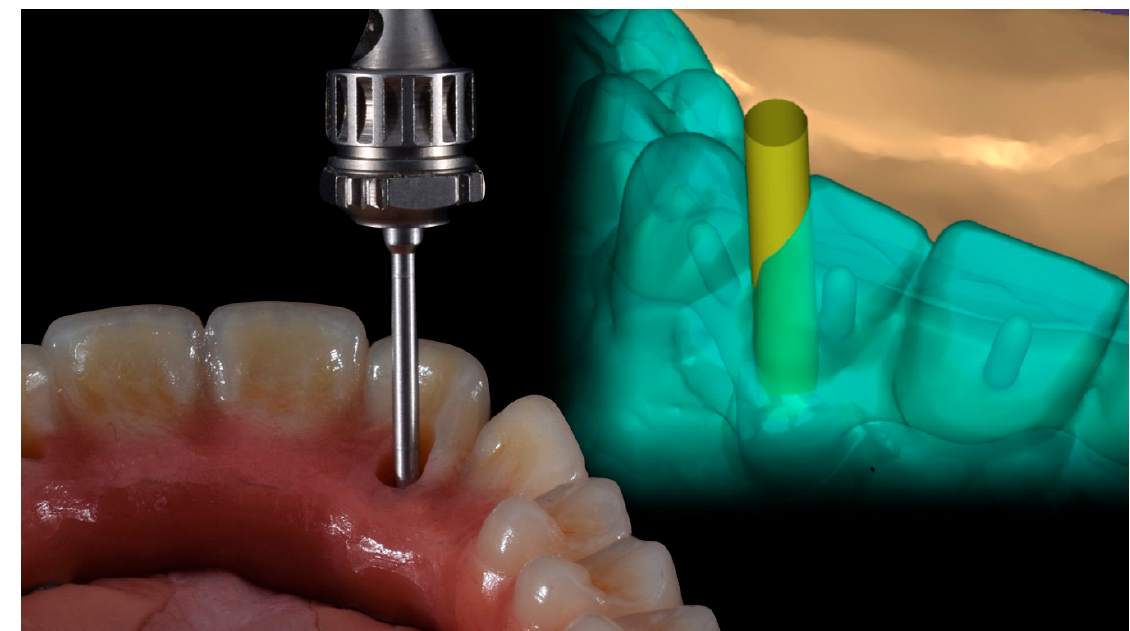
Figure 15. Angled screwdriver and the original path of the screw.